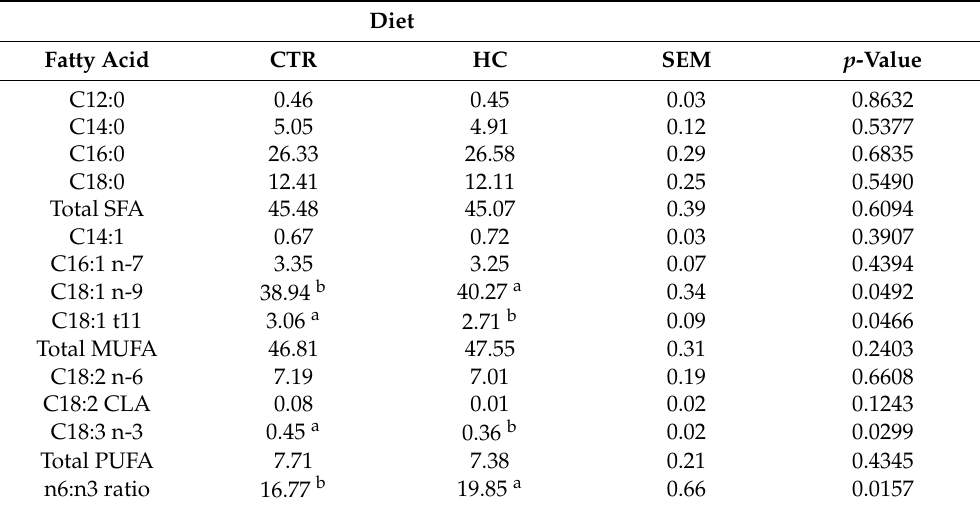
Table 6. Effect of dietary hemp cake supplementation on fatty acid profile (g/100 g of total FA) of total lipids in the Longissimus dorsi muscle of Holstein veal